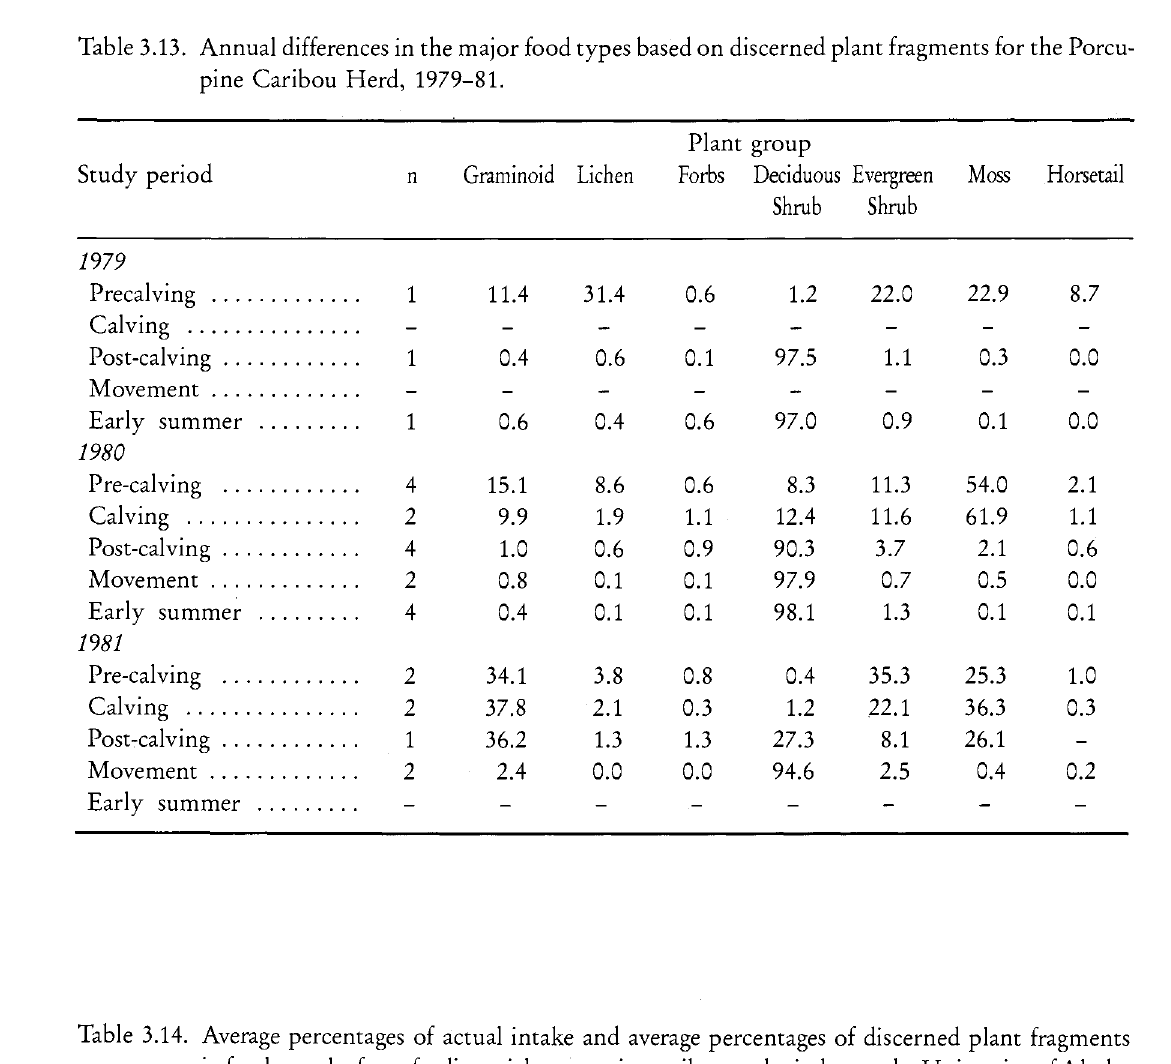
Table 3.14. Average percentages of actual intake and average percentages of discerned plant fragments in fecal samples from feeding trials on captive caribou and reindeer at the University of Alaska in 1982 by L.